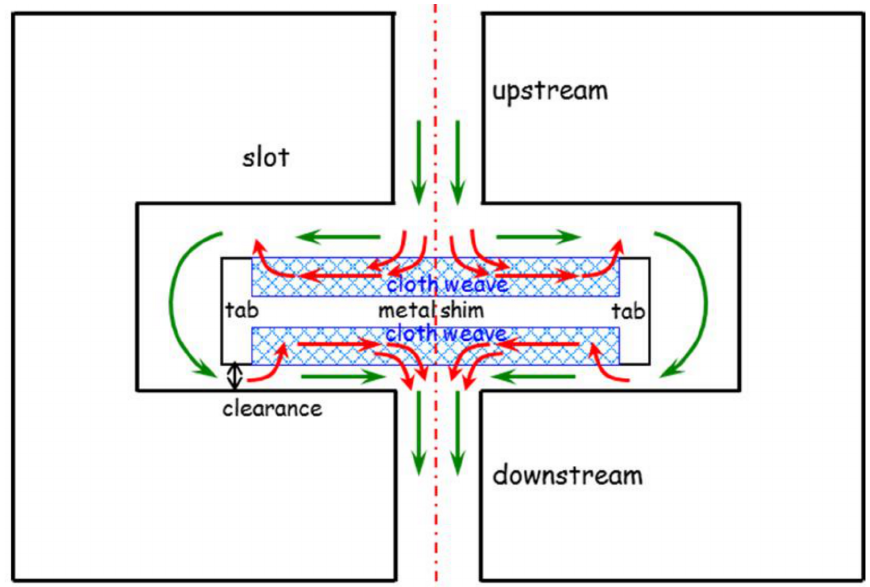
Figure 2. Schematic of a typical cloth seal application in a gas